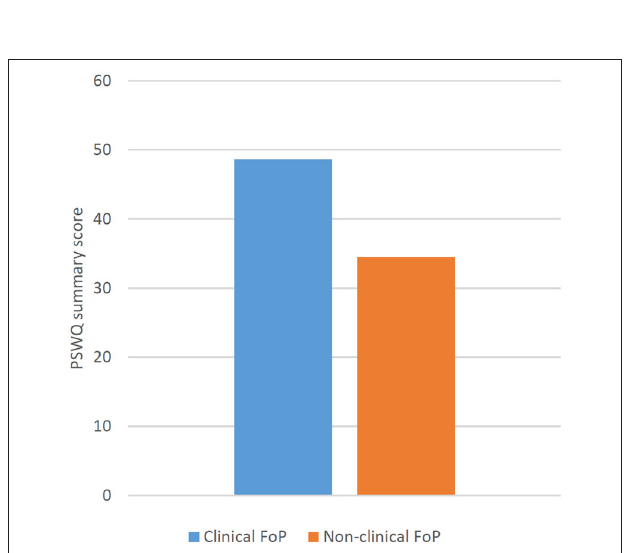
FIGURE 2 | Differences in the summary scale score of the Penn State Worry Questionnaire between patients with cancer with clinical versus non-clinical FoP (FoP-Q; cut off: 80th